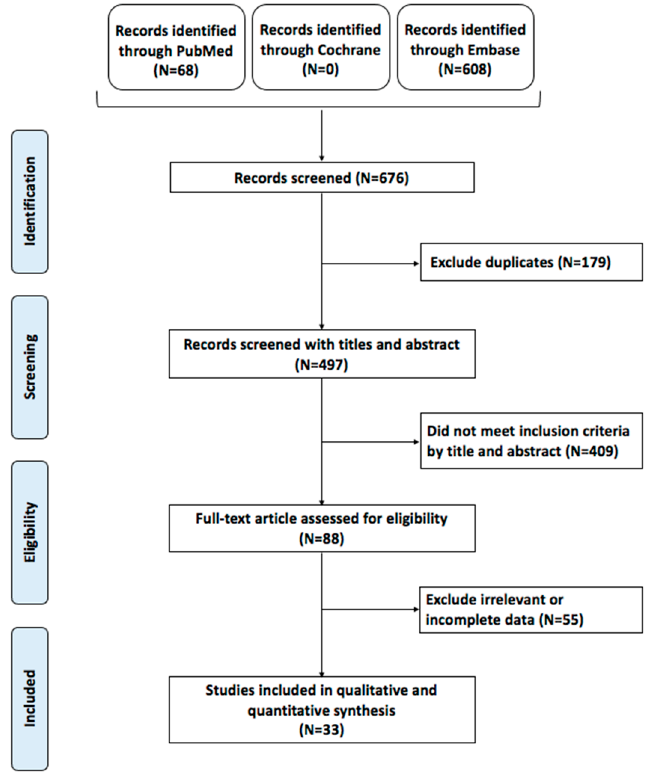
Figure 1. Preferred reporting items for systematic reviews and meta-analyses (PRISMA) flow chart of the included studies.